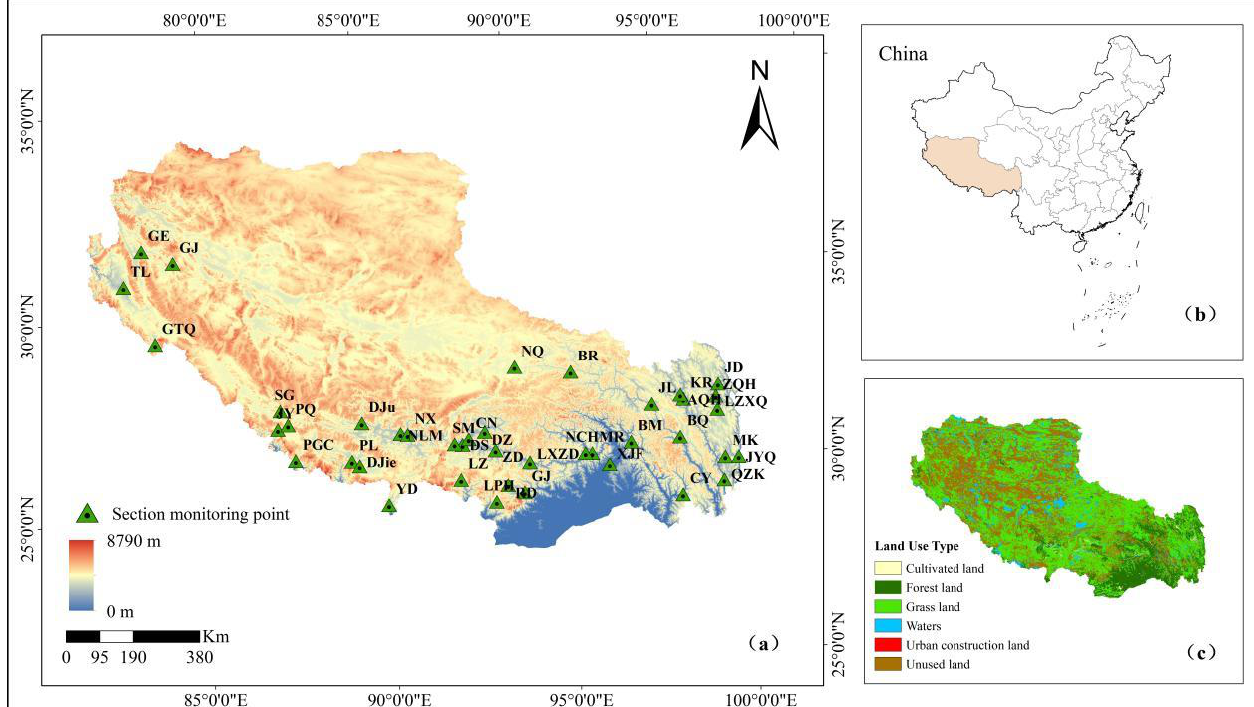
Figure 1. ( a ) Specific location map of monitoring sections in Tibet, China; ( b ) Geographic location map; ( c ) Land use map of the study area.